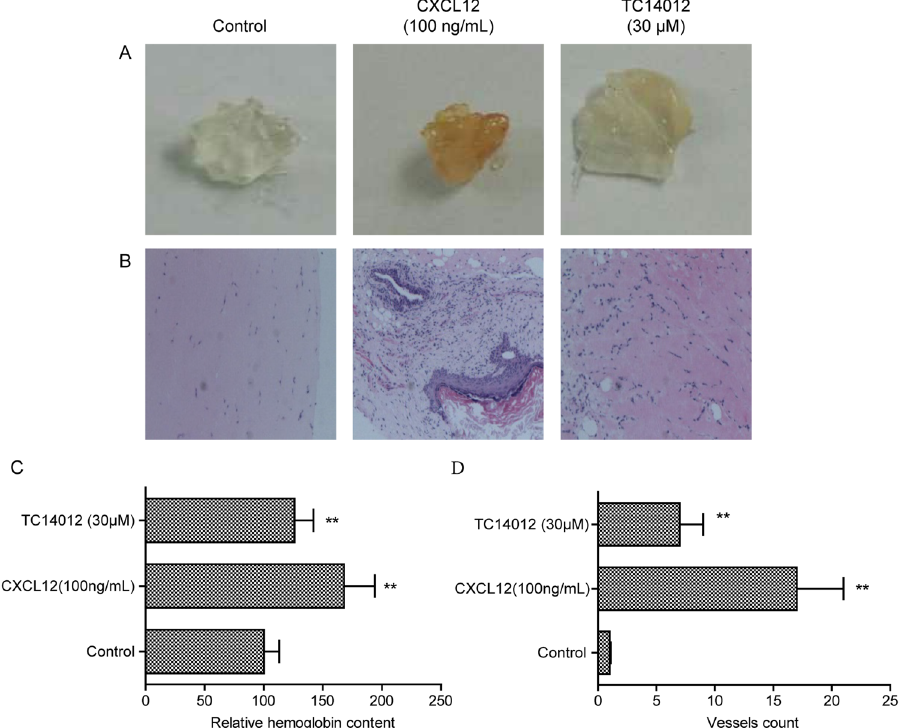
Figure 5. Activation of CXCR7 induces angiogenesis in vivo . ( A ) Mice were injected with Matrigel-containing CXCL12 (100 ng/mL) or TC14012 (30 μ M) as indicted to induce angiogenesis in vivo for 10 days, Matrigel plugs were removed. ( B ) Representative HE staining of Matrigel plugs from control group, CXCL12 treated group and TC14012 treated group. Magnification 40 × . ( C ) Quantification of hemoglobin content in the Matrigel plugs. ( D ) Quantification of the number of vessels in sections B. Values are shown as mean ± SD; * p < 0.05/ ** p < 0.01 versus